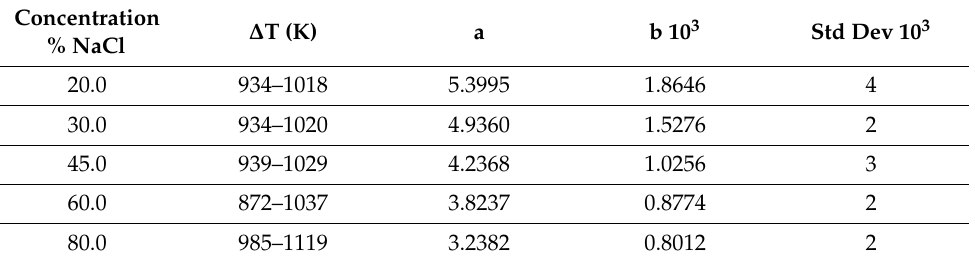
Table 1. Concentration-dependent densities for the system NaCl-UCl 3 -UCl 4 with the uranium salt composition 30% UCl 3 + 70% UCl 4 and varying NaCl concentrations, part reprinted from [24]. The experimental error in the density measurements is presented with max ±